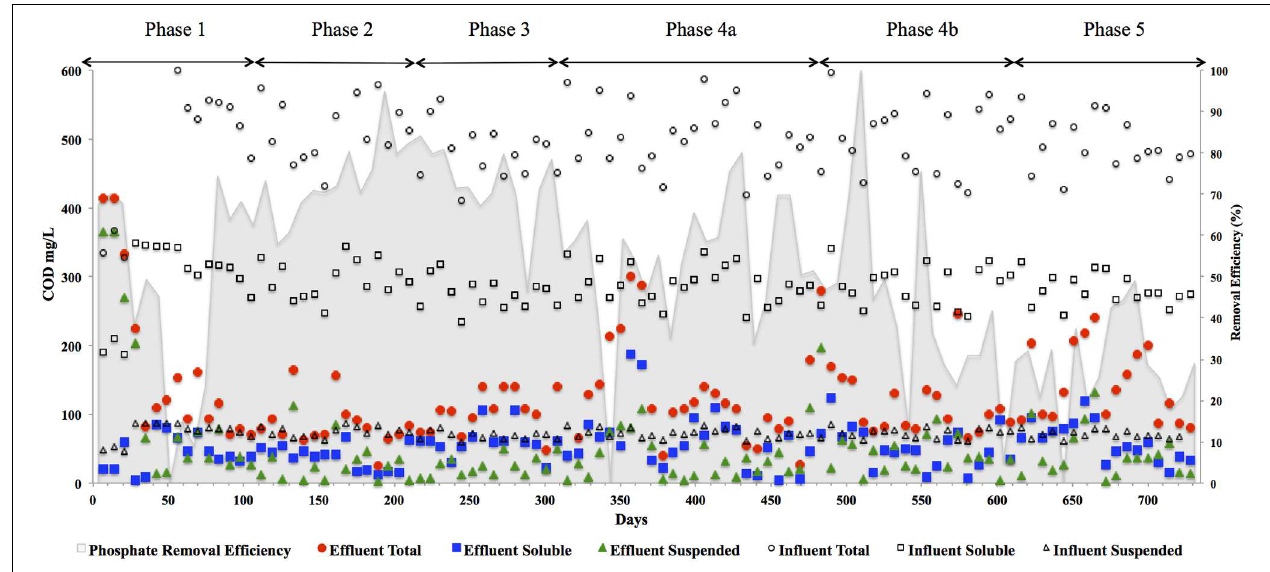
FIGURE 3 | COD total , COD soluble , COD suspended , and COD colloidal concentrations in (mg l − 1 ) in the reactor effluent for the five phases of reactor ), Effluent Soluble ( (cid:4) ), Effluent Suspended ( (cid:78) ), Influent Total ( (cid:13) ), Influent Soluble ( (cid:3) ), Influent Suspended ( (cid:77) ), and Influent Colloidal ( ♦ ) operation. Effluent Total ( and phosphate removal (%) [based on an average influent concentration of 34 mg l − 1 ] in shading on secondary (cid:32)